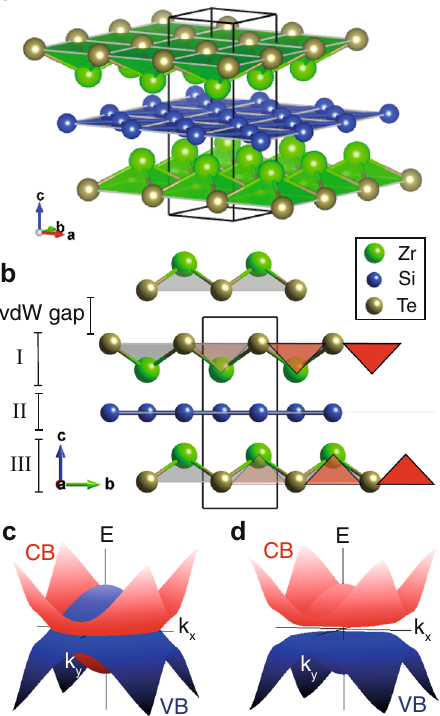
Fig. 2 Crystal structure and low-energy electronic structure of ZrSiTe. a The unit cell. Green, blue, and bronze balls represent the Zr, Si, and Te atoms, respectively. b Side view of the unit cell, highlighting the ZrTe sectors (I and III) and the Si plane (II). Red triangles picture the orientation of the ZrTe 4 square pyramids. c Artist ’ s view of the valence (VB) and conduction (CB) bands, without spin – orbit coupling (SOC). The crossing constitutes the nodal-line. d SOC opens a gap along the nodal